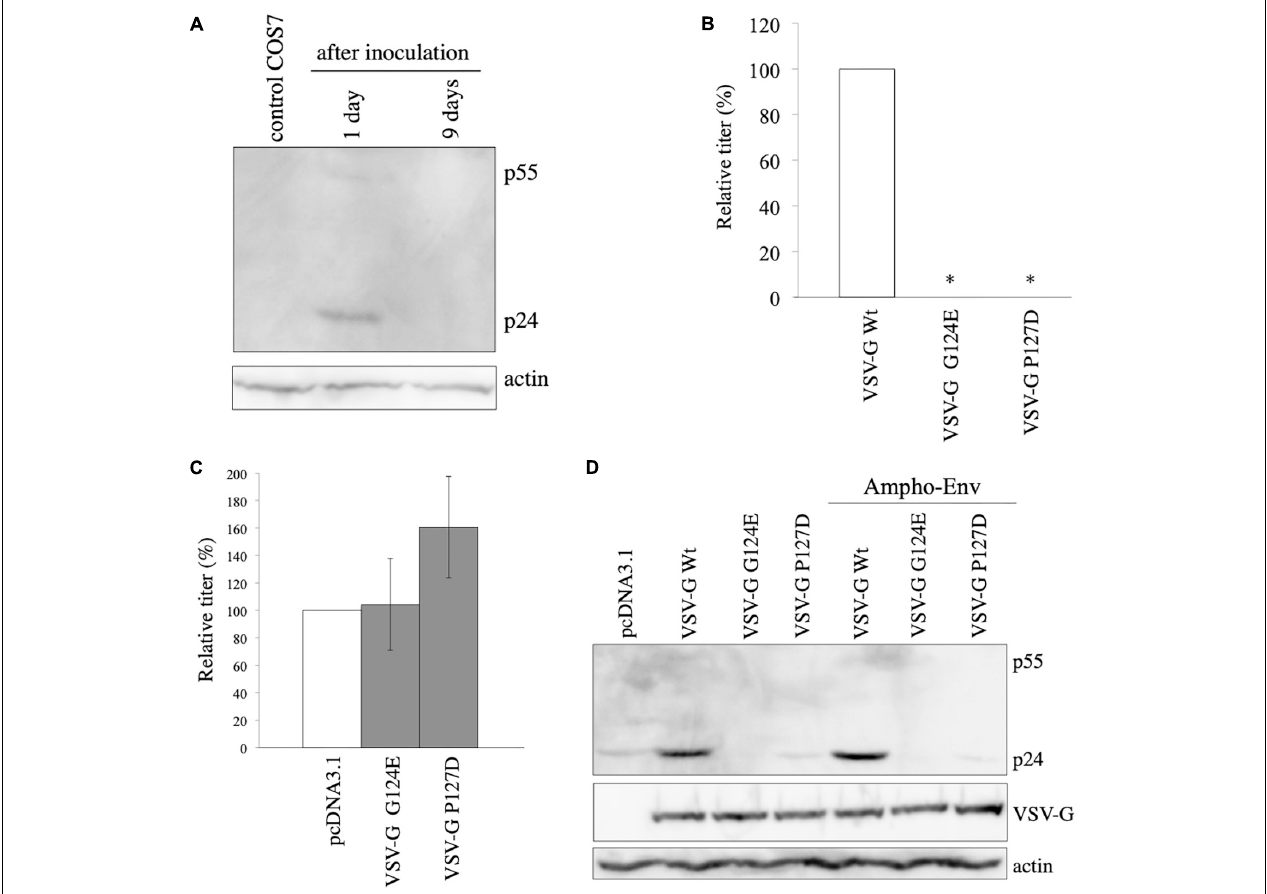
FIGURE 2 | VSV-G-mediated increase of HIV-1 Gag protein is not induced by retro-transduction. (A) COS7 cells were inoculated with VSV-G-pseudotyped HIV-1 vector. Cell lysates were prepared from the inoculated cells 1 and 9 days after the inoculation. Gag protein was analyzed by western blotting. HIV-1 Gag precursor (p55) and mature capsid (p24) were indicated. (B) Transduction titers of HIV-1 vector carrying VSV-G Wt, G124E, or P127D were measured. Relative values to the transduction titers of VSV-G Wt-carrying HIV-1 vector are indicated ( n = 3). Asterisks show significant differences compared to VSV-G Wt. (C) 293T cells were transfected with amphotropic MLV-pseudotyped HIV-1 vector construction plasmids together with VSV-G G124E- or P127D plasmid. Relative values to the transduction titers of pcDNA3.1-transfected cells are shown ( n = 3). (D) 293T cells were transfected with HIV-1 Gag-Pol expression plasmid together with VSV-G Wt, G124E, or P127D plamid in the absence or presence of amphotropic MLV Env expression plasmid. Cell lysates were prepared from the transfected cells. Gag, VSV-G, and actin proteins were analyzed by western